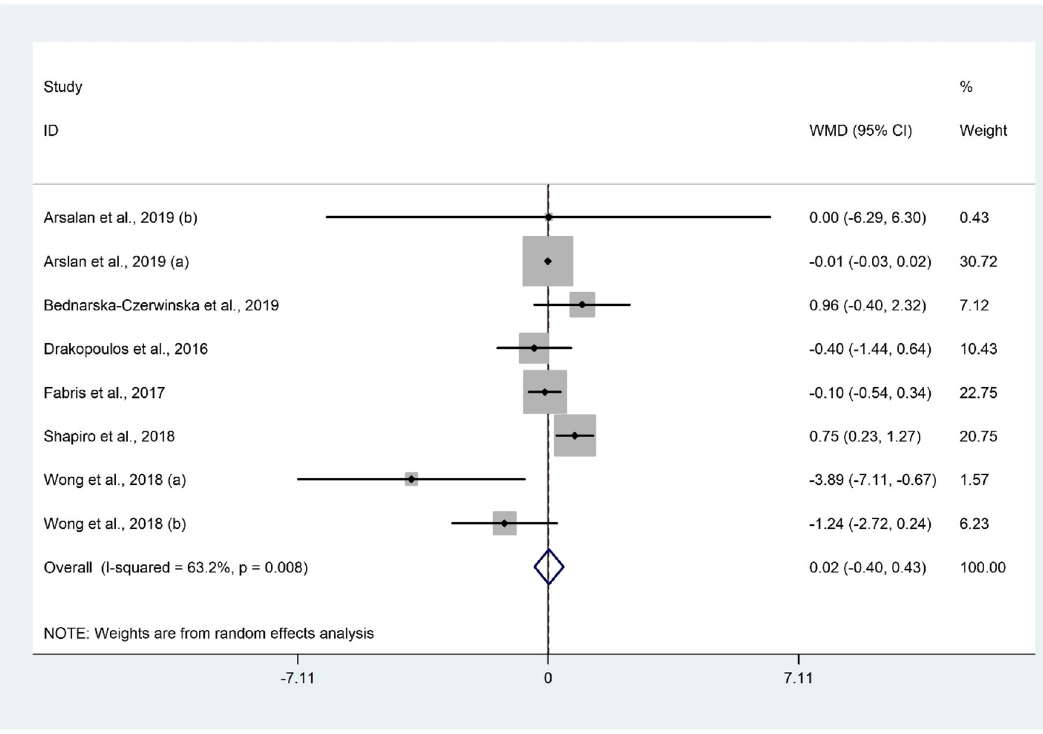
Figure 3. Forrest plot of the comparison of the AMH between women with vitamin D insufficiency/deficiency and sufficient ones.